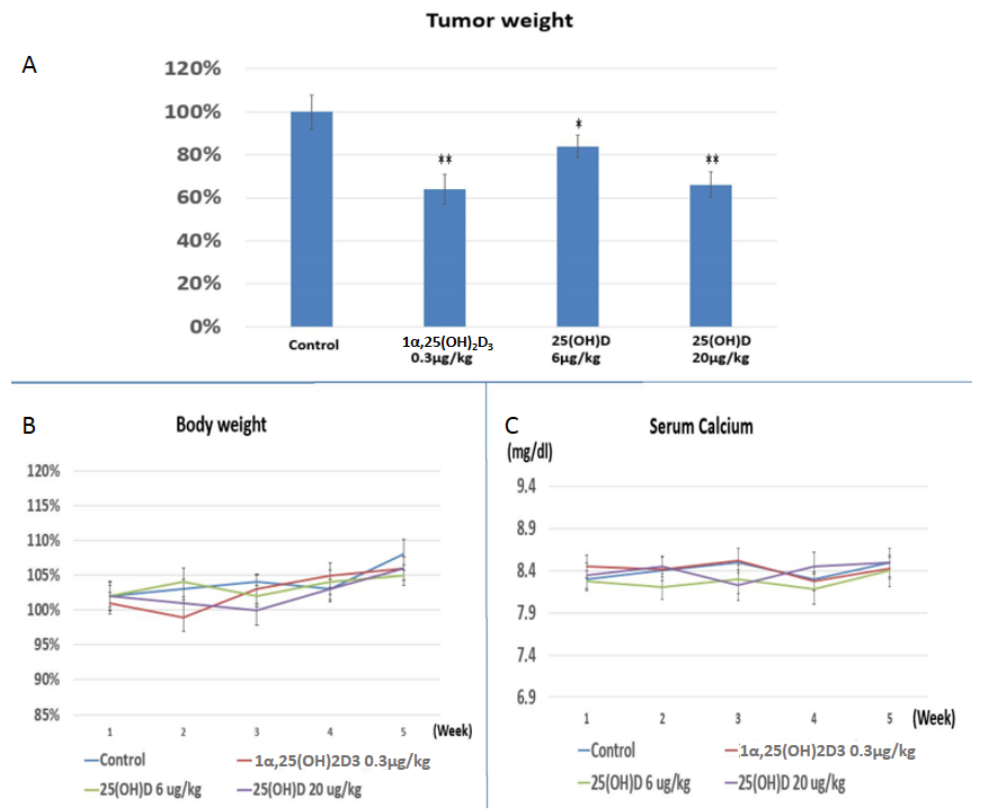
Figure 4. Evaluation of 25(OH)D and 1 α ,25(OH) 2 D 3 effect on SNU308 cells growth in vivo through a xenograft animal model. ( A ) Four weeks after treatment, the xenografted tumors from each group were weighed; ( B ) The body weight of nude mice in each group; ( C ) The serum calcium concentration of nude mice in each group. Each value is a mean ± SD of six determinations. * p < 0.05, ** p < 0.001 versus control.